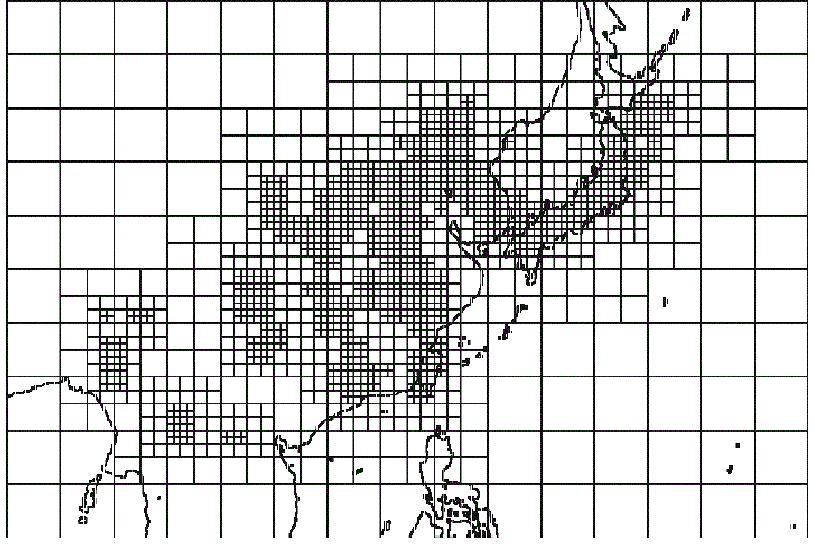
Figure 4. Block-structured dynamically refined grid over East Asia. Reprinted with permission from